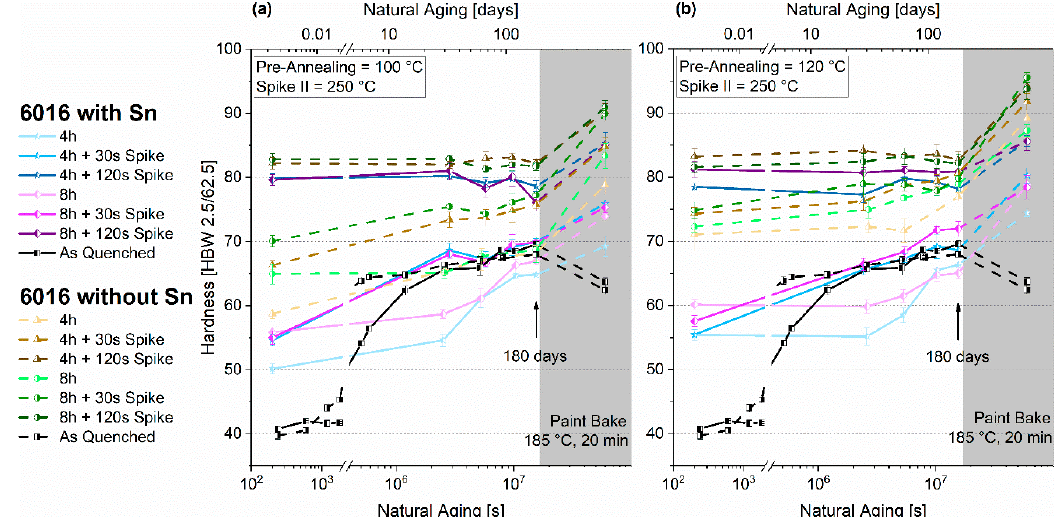
Figure 10. Natural aging behavior and paint-bake response of samples treated according to PA3 for EN-AW-6016 Sn-free and EN-AW-6016 + 100 at.-ppm Sn PA at 100 ◦ C + Spike II 250 ◦ C ( a ) and PA at 120 ◦ C + Spike II 250 ◦ C ( b ). The shaded areas show the hardness evolution during the paint-bake treatment (185 ◦ C, 20 min, no pre-deformation).